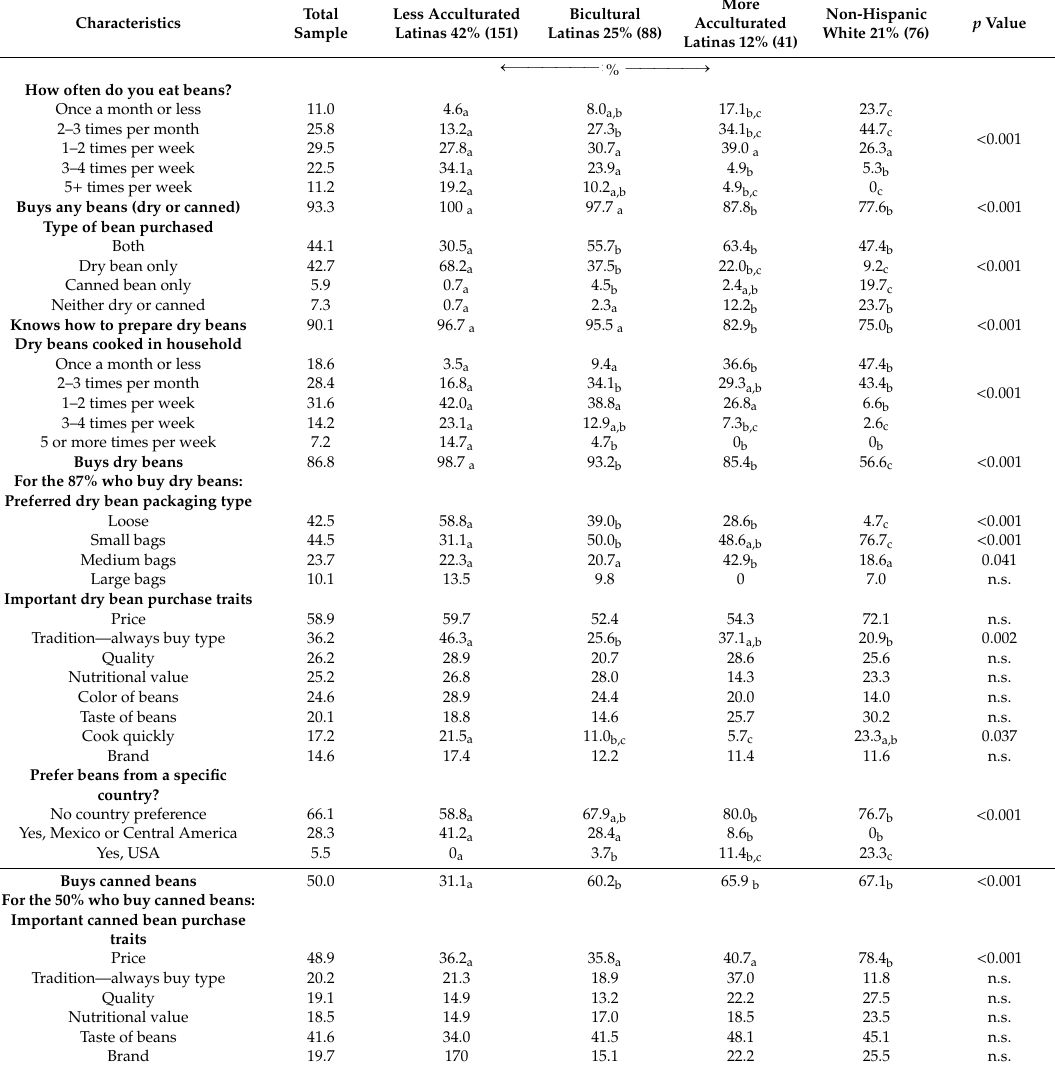
Table 2. Bean purchasing practices and preferences of low-income Arizona women by Bidimensional Acculturation Scale categories ( N = 356).